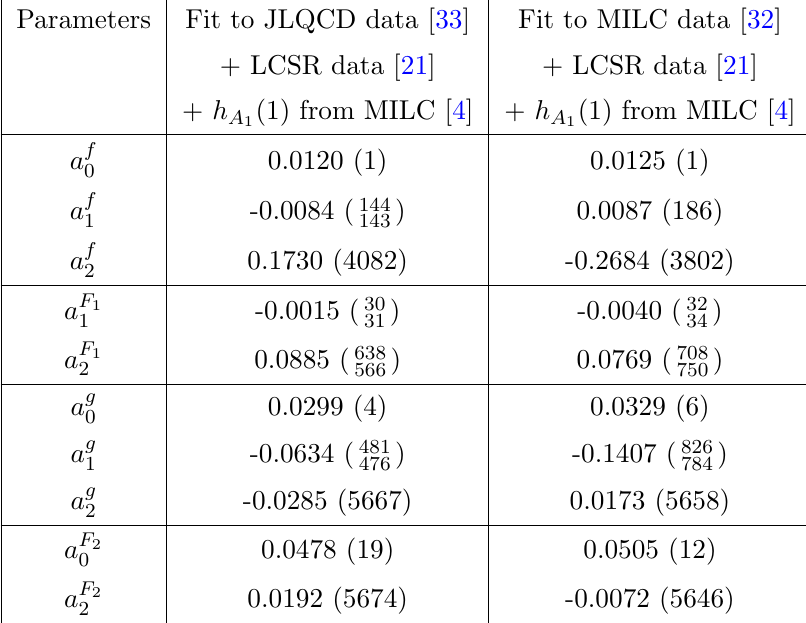
(1) = 0 : 906(13) is taken from unquenched 1